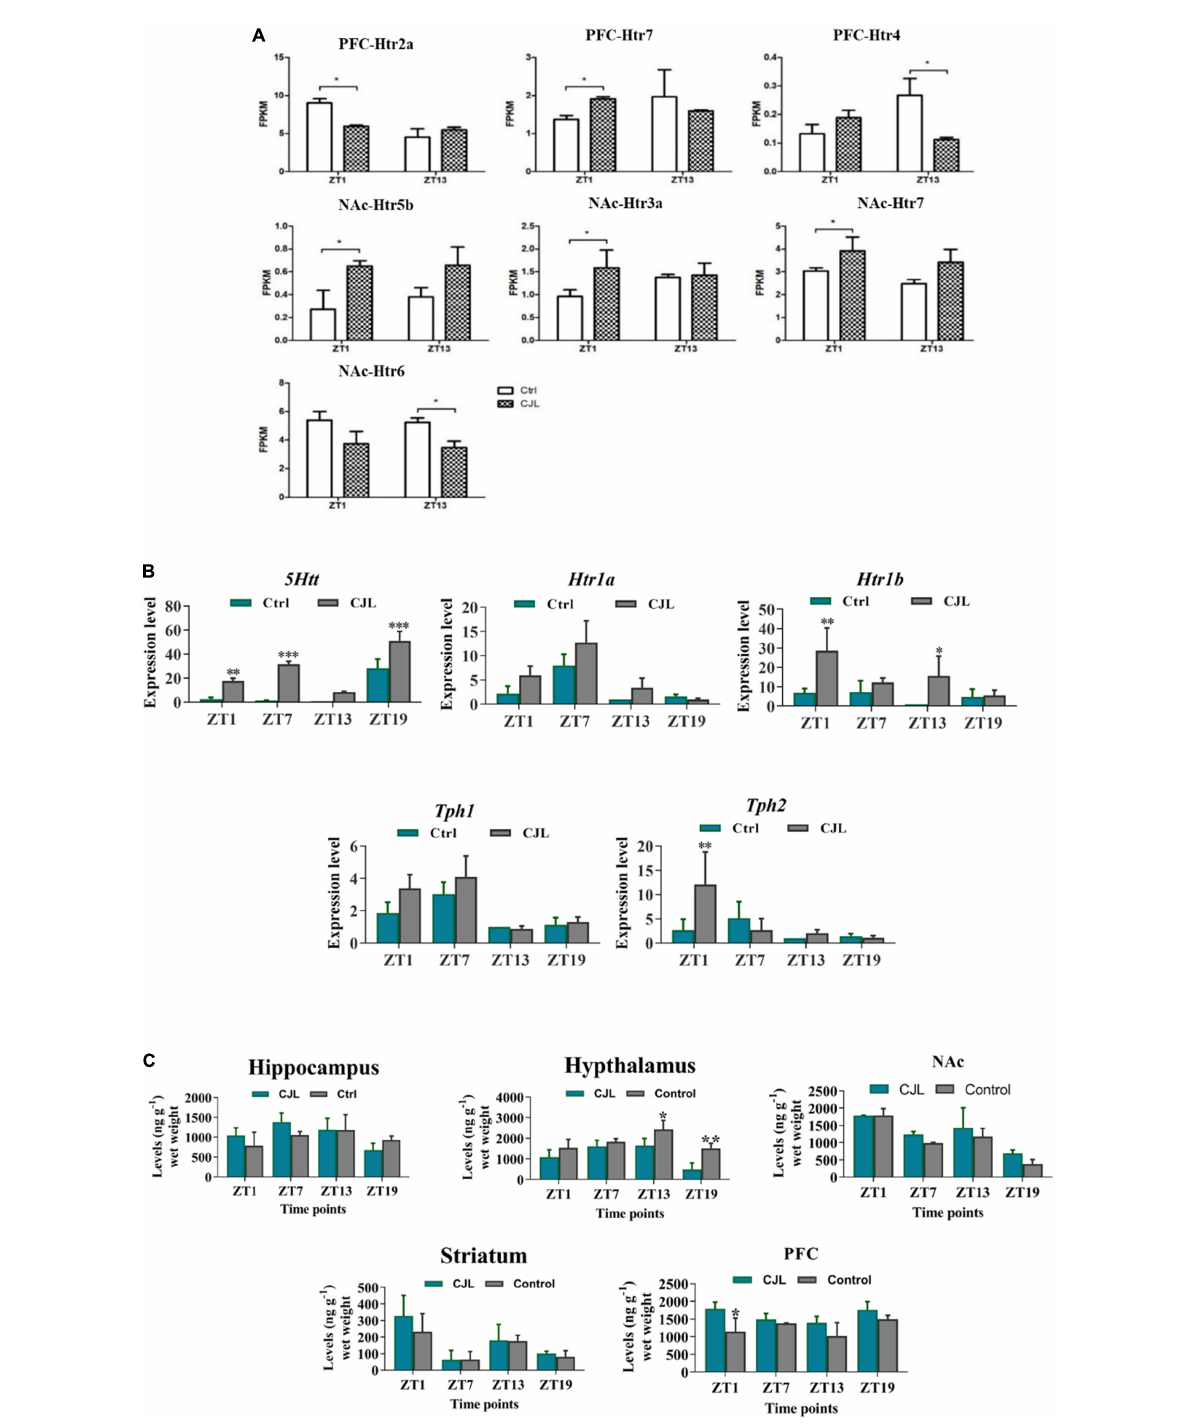
FIGURE7 Chronic jetlag (CJL) disrupts serotonin regulation in the brain. (A) CJL altered the levels of 5-HT receptors and transporters in the nucleus accumbens and prefrontal cortex (detected by RNA sequencing). All data are presented as means ± SEM, * P < 0.05. (B) CJL altered 5Htt mRNA in the raphe nucleus. This figure shows mRNA levels in raphe nucleus extracts from baseline and CJL treated animals ( n = 3 per group), as assayed by three independent qPCR assays, at four different time points (ZT1, ZT7, ZT13, and ZT19). Results are expressed as mean ± SEM. ** P < 0.01, *** P < 0.001, two-way ANOVA. Panel (C) represents levels (mean ng g - 1 wet weight ± SEM) of dopamine (5-HT) in the hippocampus, hypothalamus, striatum, frontal cortex, accumbens as determined by fluorospectrophotometry. * P < 0.05, ** P < 0.01, *** P < 0.001 ( n = 304), two-way